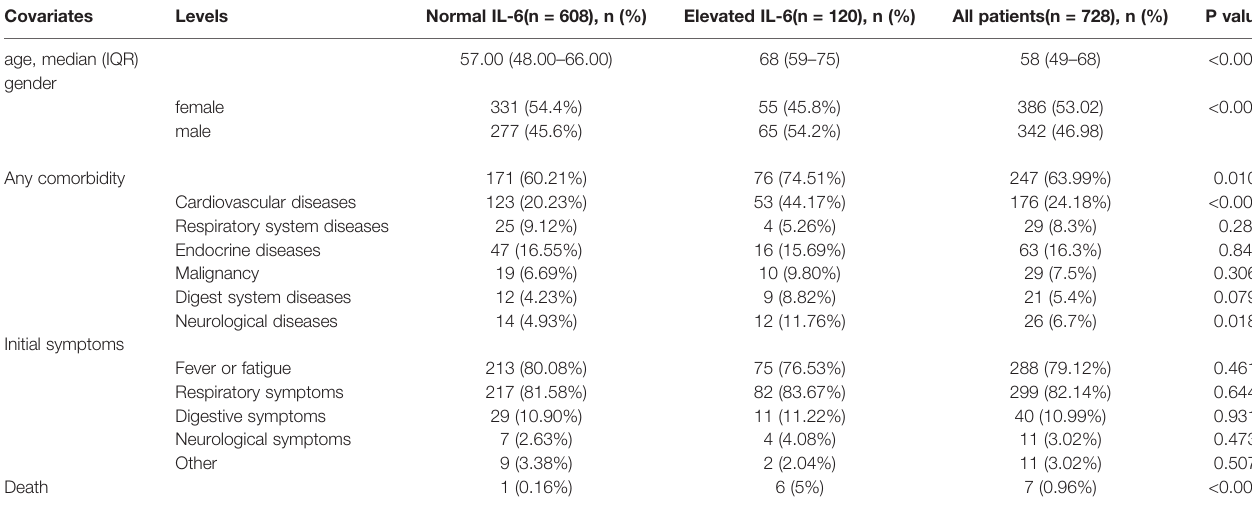
TABLE 1 | Demographic characteristics and symptoms of 728 patients with COVID-19. Covariates